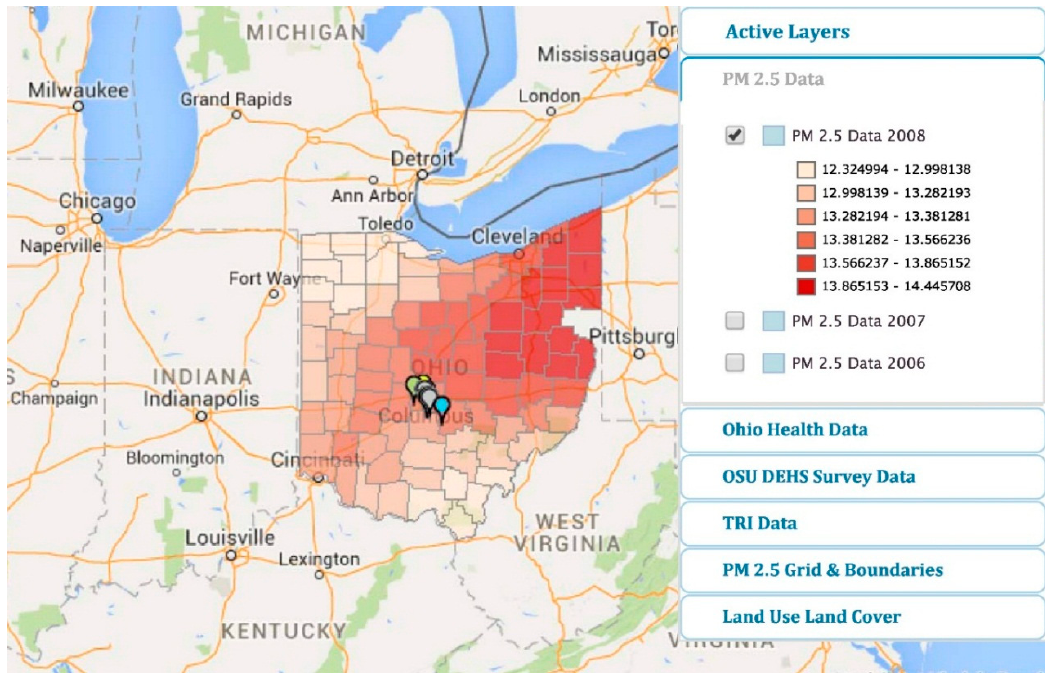
Figure 2. Spatiotemporal presentation of PM 2.5 data from the 88 counties in Ohio from the NASA MODIS satellite available at MapplerX [49]. TRI, Toxic Release Inventory. OSU, The Ohio State University; DEHS, Division of Environmental Health Sciences.